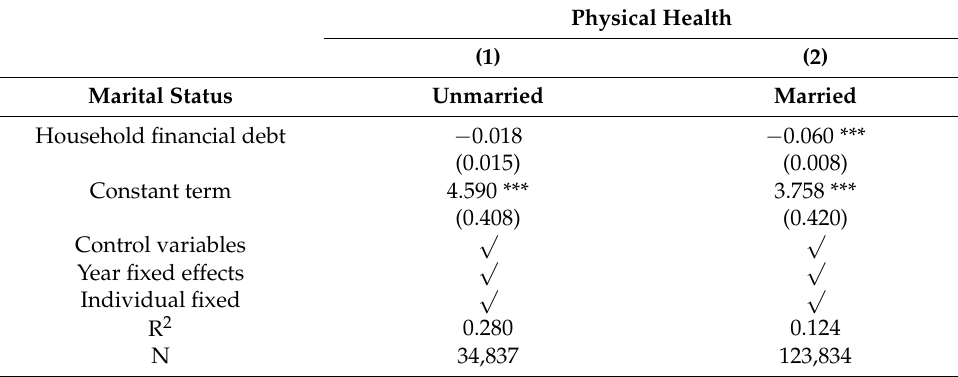
Table 8. Regression results of marital